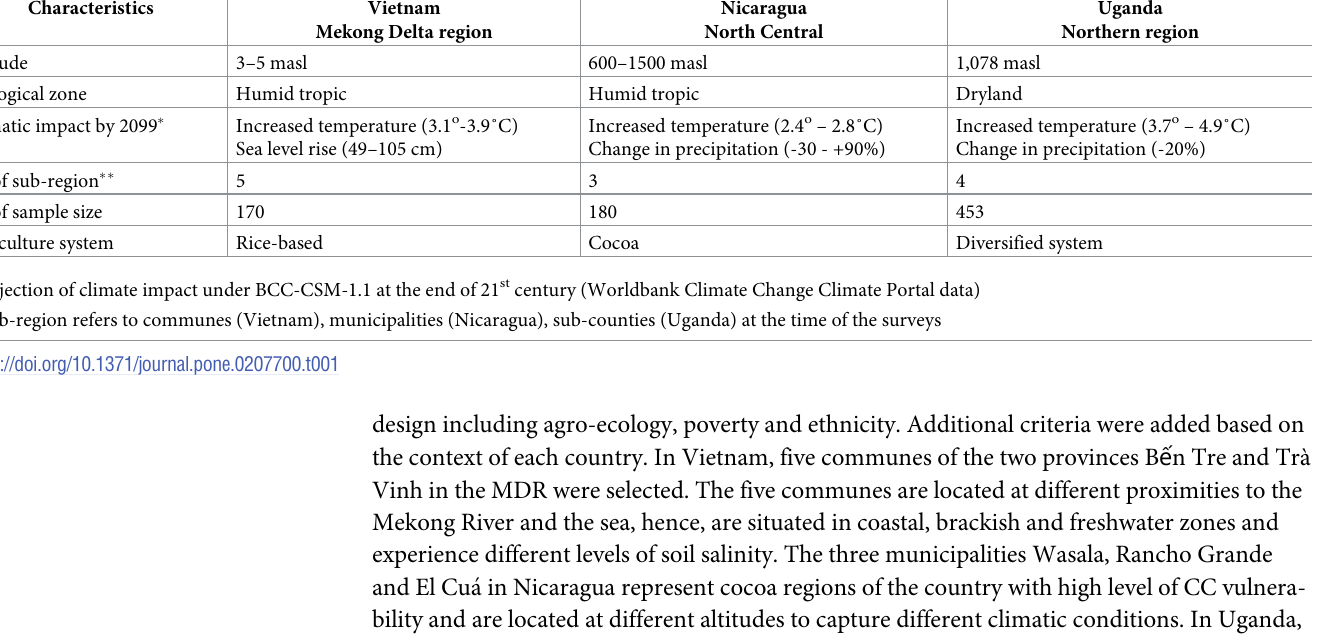
Table 1. Overview of three study sites Vietnam, Nicaragua and Uganda.